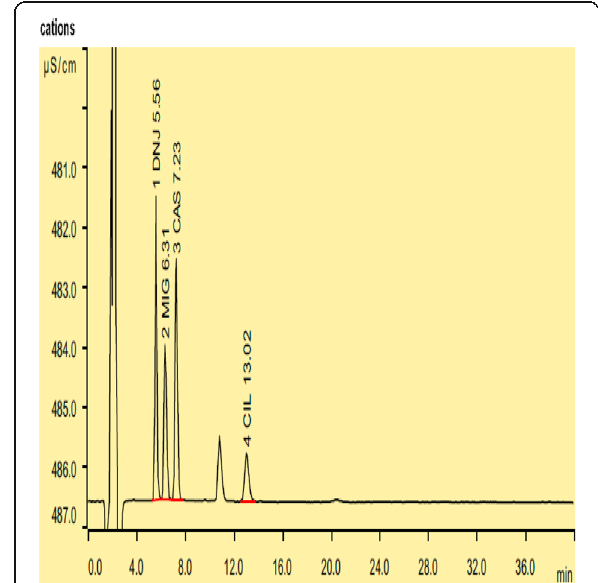
Fig. 2 Development of Aza sugars (1-deoxynojirimycin, miglitol, castanospermin, and celgosivir) with universal cation column in ion chromatography